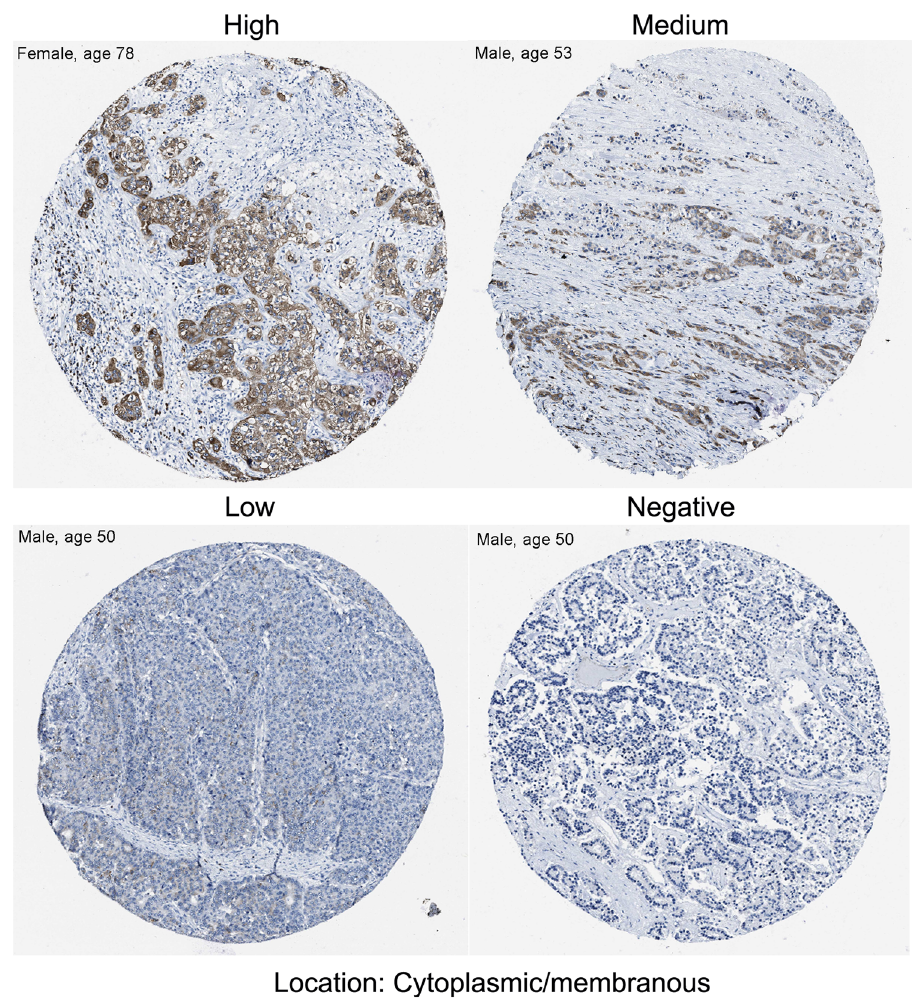
Figure 3: Immunohistochemistry analysis of the ITGA3 protein in the pancreatic cancer tumor tissues. Antibody: CAB018594; Cancer type: Adenocarcinoma. The origin of tissues was Pancreas ( T - 59000 ) . Staining: High, Medium, Low, and Negative. The representative images of immunohistochemistry of ITGA3 protein were extracted from the human protein atlas ( HPA, https://www.proteinatlas.org/ )